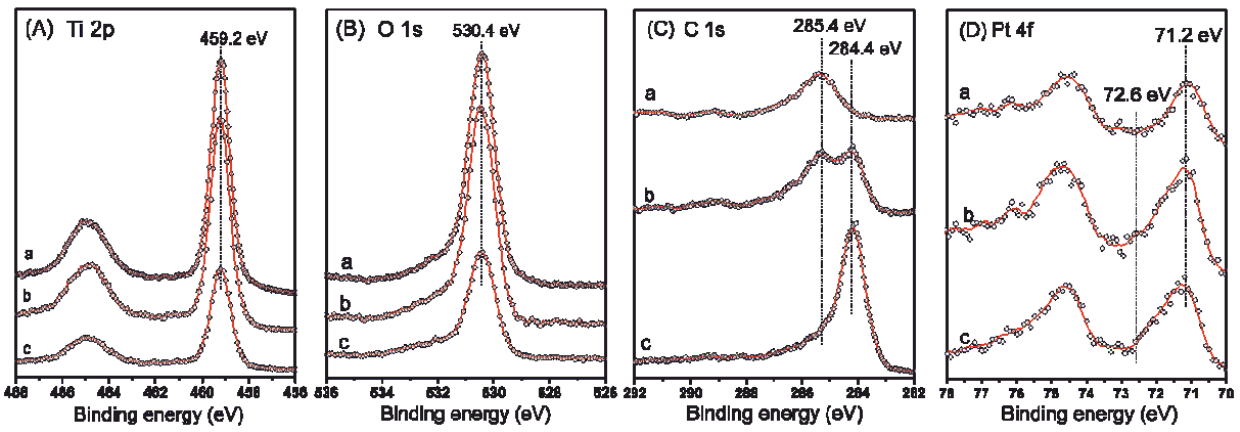
Figure 5. XP Ti 2p ( A ), O 1s ( B ), C 1s ( C ) and Pt 4f ( D ) spectra for TiO 2−δ (a), CNT-TiO 2−δ -15 (b) and CNT-TiO 2−δ -60 (c) with photodeposited Pt (0.1 wt%) after photocatalytic